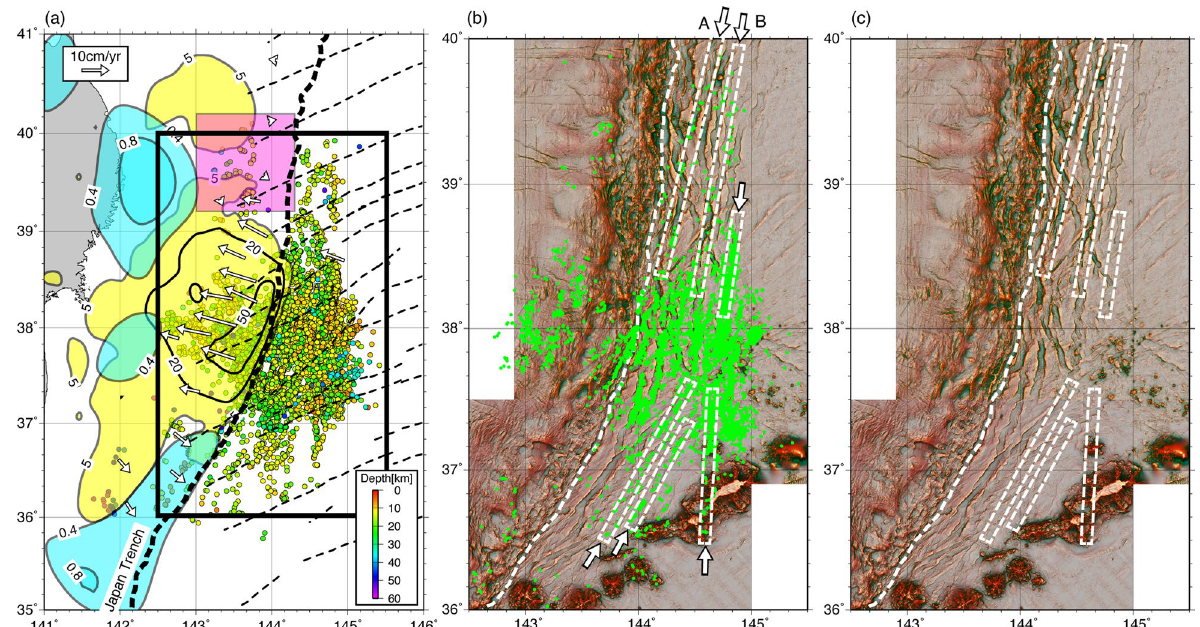
the Moho, which is 7 km below the seafloor seaward of the trench and 6 km below the top of the oceanic crust landward of the trench. Inverted triangles indicate the projected locations of OBSs. White contours are iso- velocity contours of Vp. Fig. S3 . Results of the tomographic analysis and checkerboard resolution test. a Map showing the obtained Vp model at a depth of 15 km. Symbols are the same as in Fig. S2. b , c Cross sections of Vp ( b ) and Vs ( c ) model along the profile X–X’ on panel ( a ). d Map showing the results of the checkerboard resolution test for Vp at a depth of 15 km. e , f Cross sections of the results for Vp ( e ) and Vs ( f ) along the profile X–X’ on panel ( d ). Fig. S4 . Location errors of the hypocenters estimated from 100 bootstrap samples. a Map showing error ellipsoids of hypocenter loca- tions. Error ellipsoids are color-coded by location errors. Open stars are the epicenter of three M6-class earthquakes. b Cross section of hypocenter errors projected along the profile indicated by a thick solid line on panel ( a ). Fig. S5 . Temporal evolution of aftershock activity for the first 24 h of the September 20, 2017 earthquake. a – f Maps and cross sections showing aftershock hypocenters for each time range, represented with circles. The origin time of the mainshock is 16:37. Aftershocks within the first hour of the mainshock are indicated in panel ( a ). Green stars indicate the hypocenter location of the mainshock. The time ranges displayed on each panel vary from 1 to 8 h. Cross sections indicate hypocenters projected along the thick solid line on the map, which represents profile A–A’ in Fig. 3. Inverted triangles indicate the OBS locations. The seafloor and the approximate depth of the Moho, 7 km below the seafloor, are indicated on the cross sections with solid and dashed lines, respectively. Fig. S6 . Coulomb stress changes at aftershock hypocenters for the September 20, 2017 earthquake. a Map and cross section indicating the definition of the west, mainshock, and east areas used in panel ( b ). Green stars are